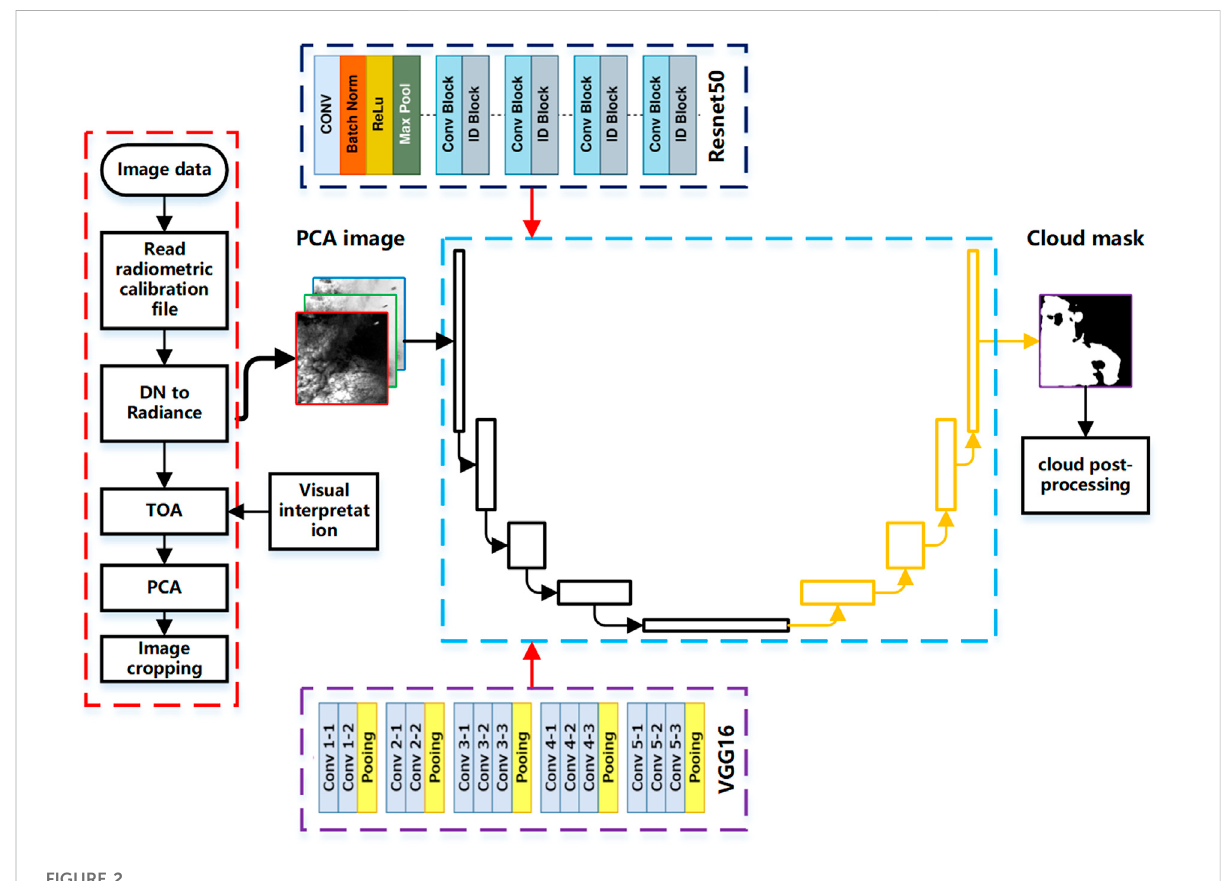
FIGURE 2 Cloud detection algorithm fl ow